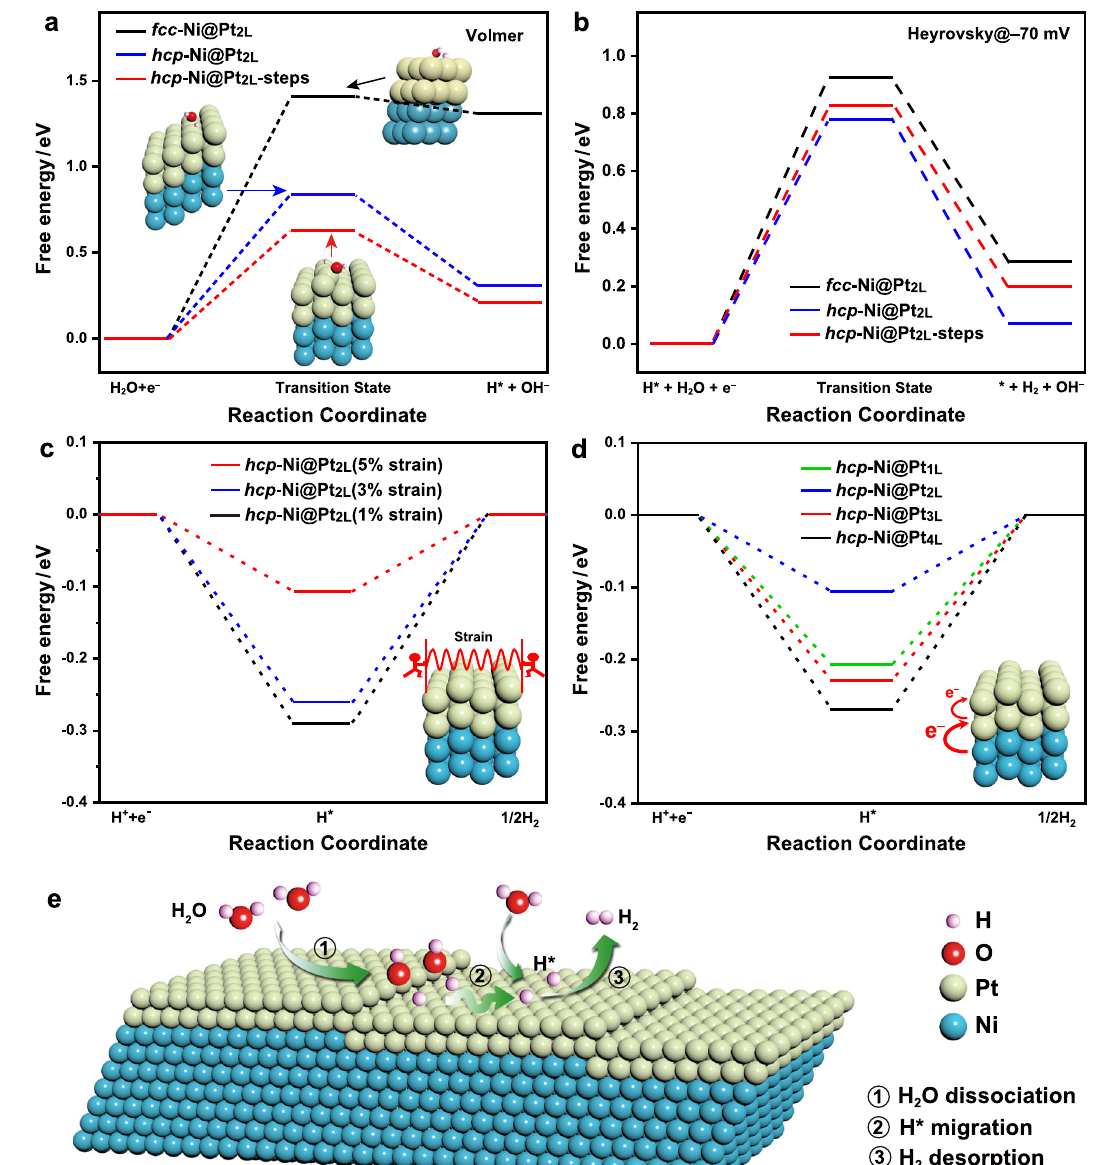
Fig. 5 | DFT calculation results. a , b Free energy diagrams of water dissociation (Volmerreaction)andhydrogendesorption(Heyrovskyreaction)at – 70mVon fcc - Ni@Pt 2L , hcp -Ni@Pt 2L , and hcp -Ni@Pt 2L with step sites, respectively. Inset: Model structures after DFT optimizations. c Hydrogen binding energies on hcp -Ni@Pt 2L with different compressive strains in the Pt kins (1%, 3%, and 5% relative to